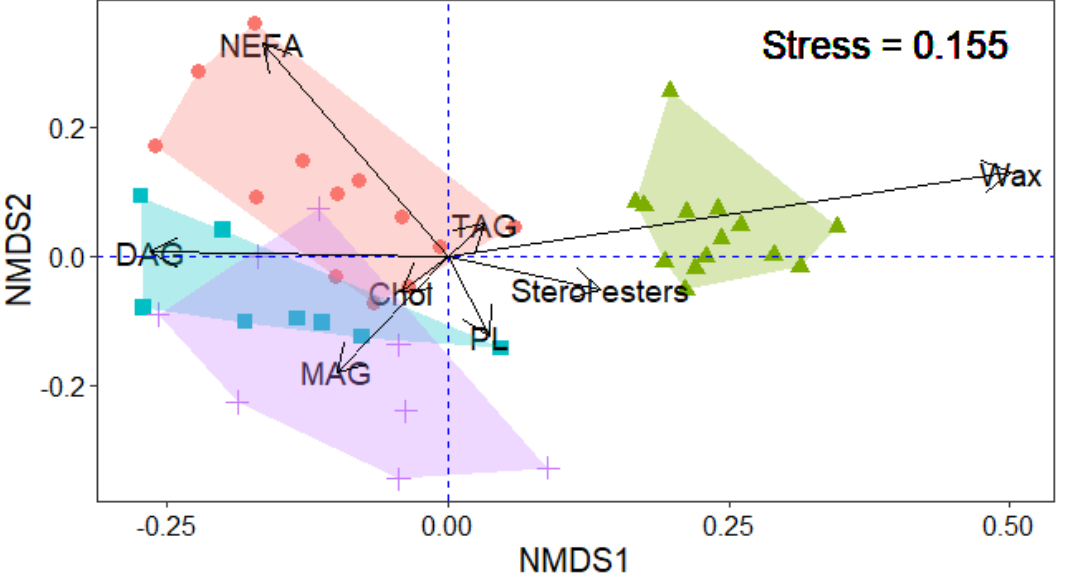
Figure 3. NMDS ordination of individual lipid classes in muscles of mesopelagic fish species ( Bathyla- gus euryops , Lampanyctus macdonaldi , Scopelogadus beanii , Serrivomer beanii ) living at different depths in the Irminger Sea (North Atlantic). Abbreviations: total phospholipids (PL), monoacylglycerols (MAG), diacylglycerols (DAG), triacylglycerols (TAG), cholesterol (Chol), non-esterified fatty acids (NEFA).